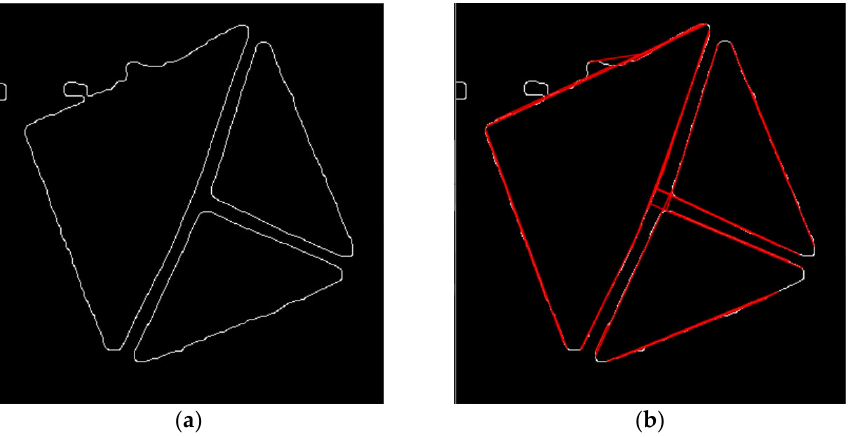
Figure 27. ( a ) image after applying Canny’s edge detector. ( b ) the same image with resulting lines of the Hough Lines algorithm lines being drawn to it.